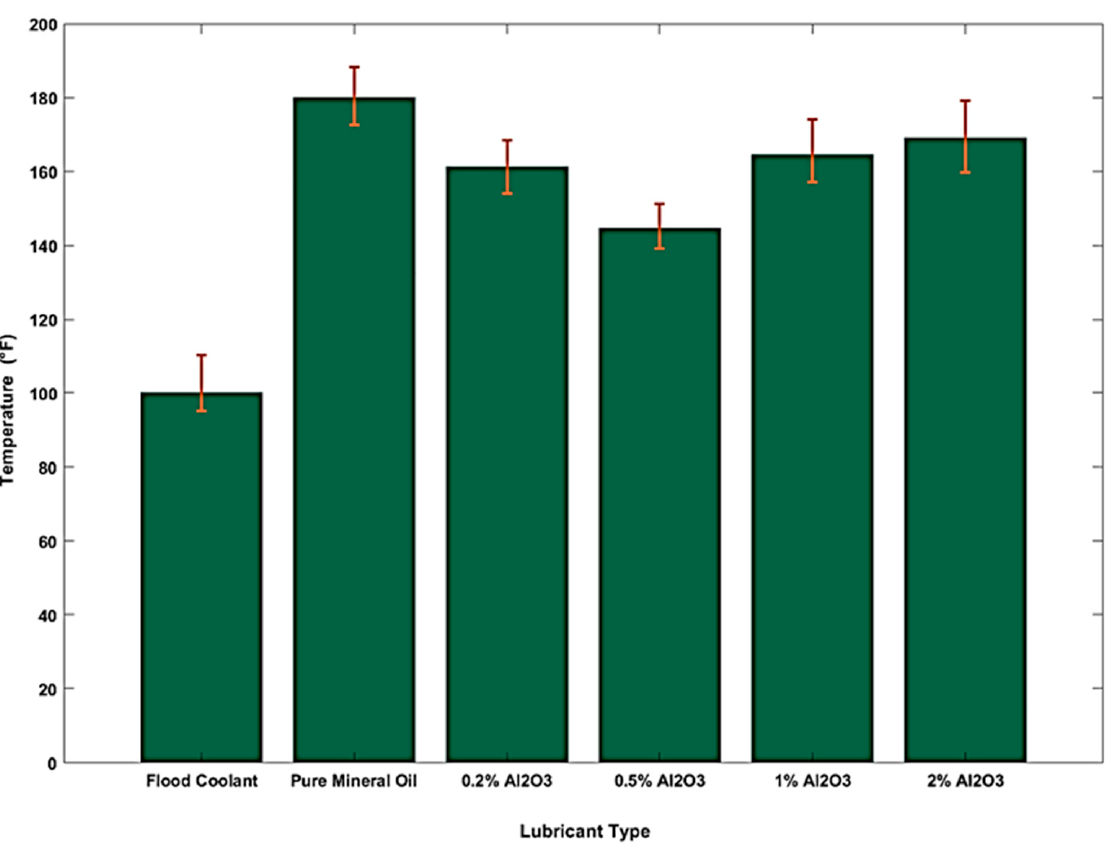
Figure 4. Temperature of the cutting zone immediately after the high-speed saw-cutting process with different lubricant types.